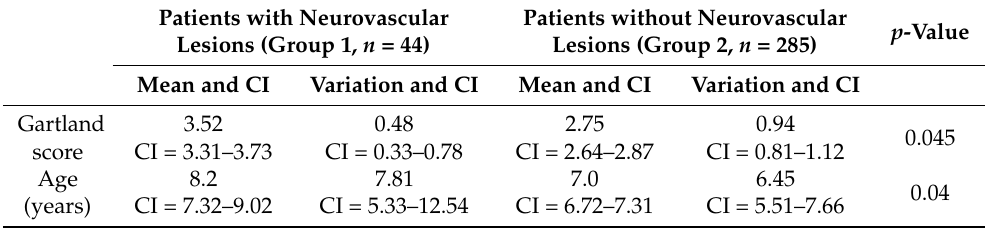
Table 4. Mean Gartland scores and variations and mean patients’ ages for the patients with and without neurovascular lesions.